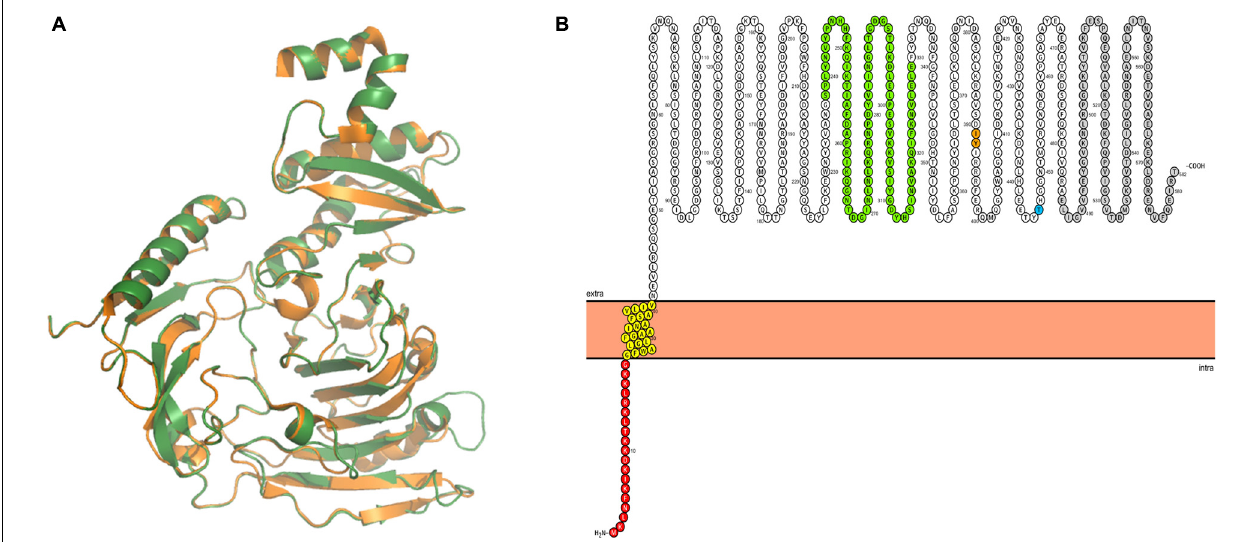
FIGURE 1 | Structural analysis of IbpM (MPN400). (A) Structural alignment of the predicted tertiary structure of IbpM from M. pneumoniae (green) to the resolved crystal structure of the antibody-binding region of Protein M (PDB: 4NZR, Grover et al., 2014) from M. genitalium (orange). The figure was created by PyMOL. (B) The ProtterBlot shows the domain architecture of IbpM (using UniProt accession number P75383) anchored in the plasma membrane. Amino acids in red indicate the signal peptide and yellow the predicted transmembrane domain. Colored residues in green indicate a leucine rich region-like domain (LRR domain) and gray the C-terminal disordered domain. Thr insertion point for the mini-transposon is indicated in orange (aa 391–392) and the truncation point for the recombinant mutant in blue (aa 446).